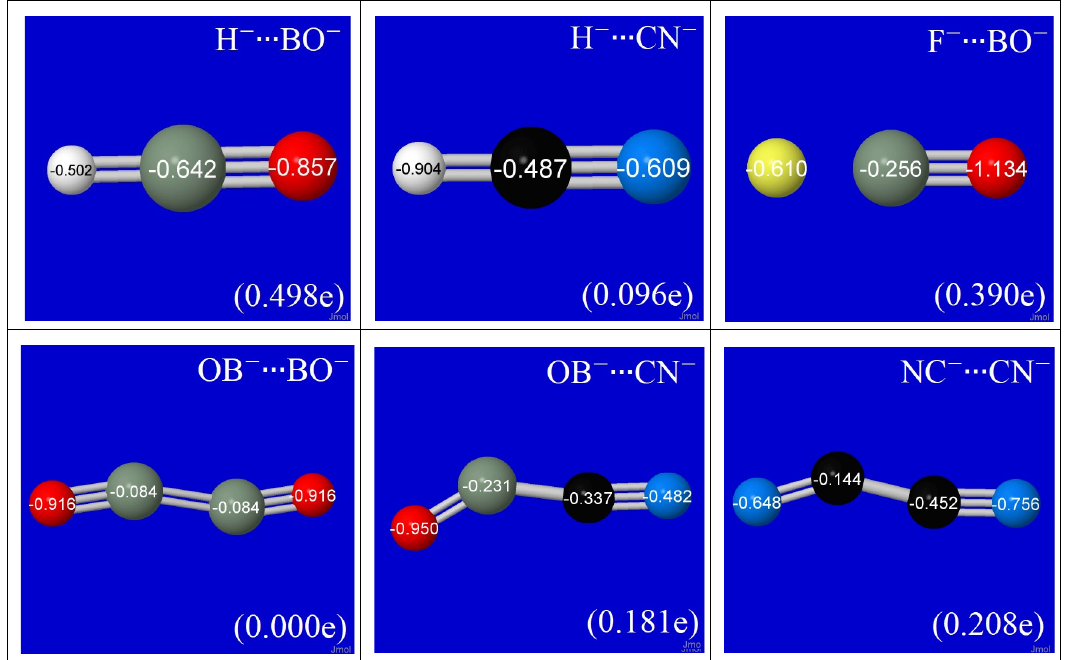
Figure 4. NPA atomic charges for equilibrium species of Figure 1, showing net charge transfer Δ Q CT (in parentheses) from donor to acceptor monomer in each species.